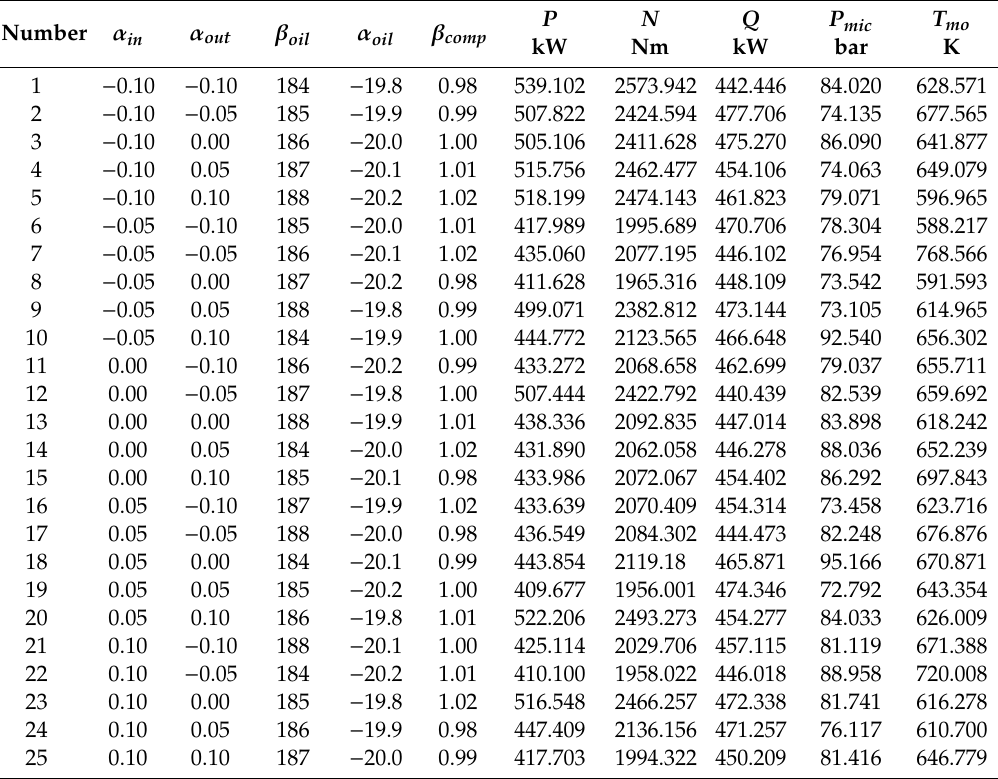
Table 5. Values and results of the orthogonal